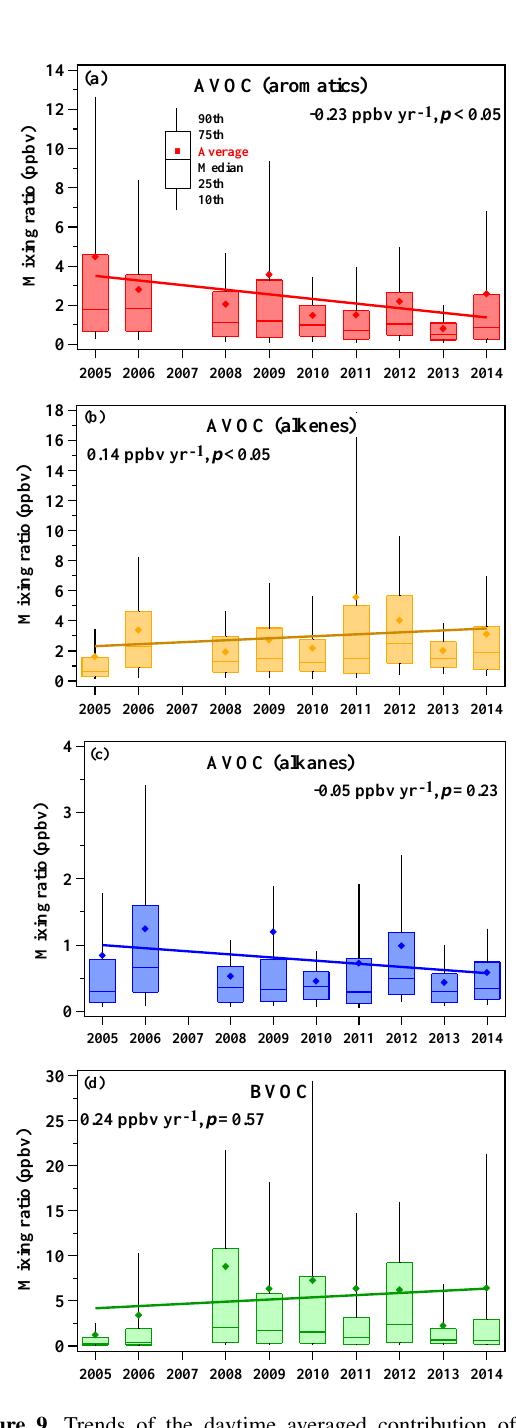
Figure 9. Trends of the daytime averaged contribution of four VOC groups to O 3 mixing ratio: (a) AVOC (aromatics), (b) AVOC (alkenes), (c) AVOC (alkanes), and (d) BVOC at TC during the pe- riod